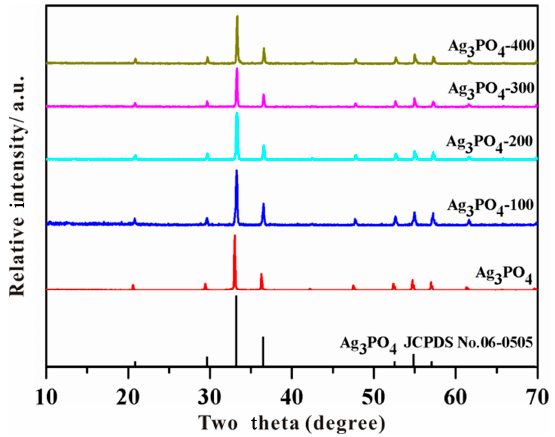
Figure 3. XRD patterns of pristine Ag 3 PO 4 and Ag 3 PO 4 -T (T = 100, 200, 300 and 400) (the standard data for body-centered cubic Ag 3 PO 4 (JCPDS No. 06-0505) are also presented at the bottom for comparison).